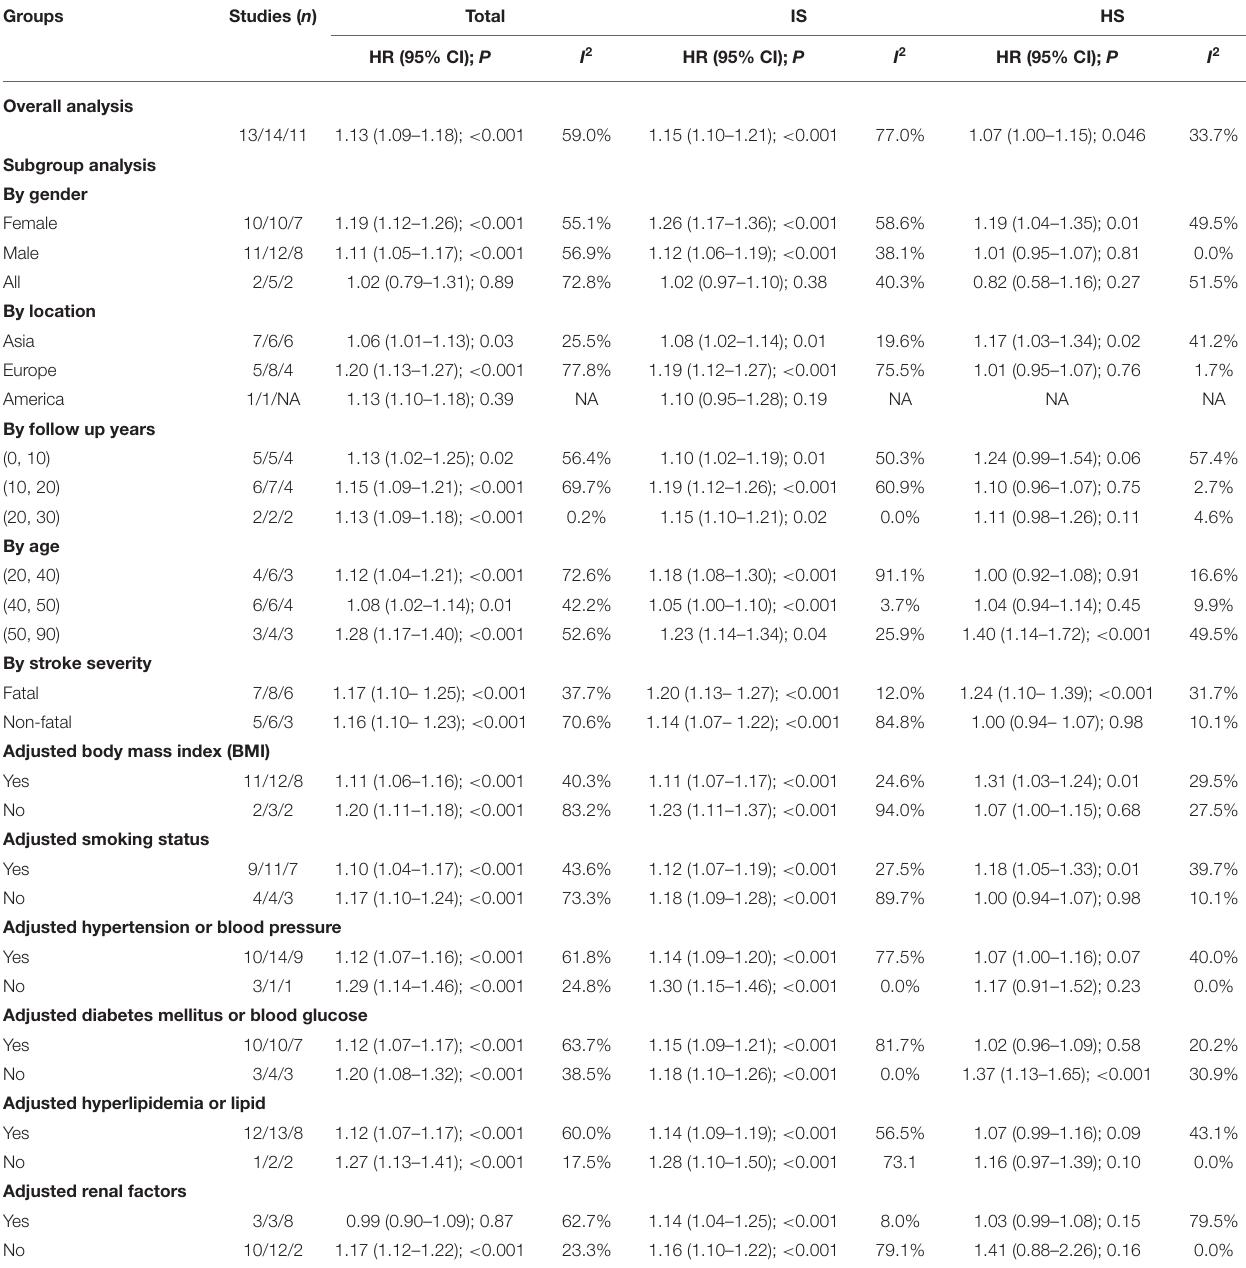
TABLE 3 | Overall and subgroup analyses of the association between UA levels and the risk of stroke.